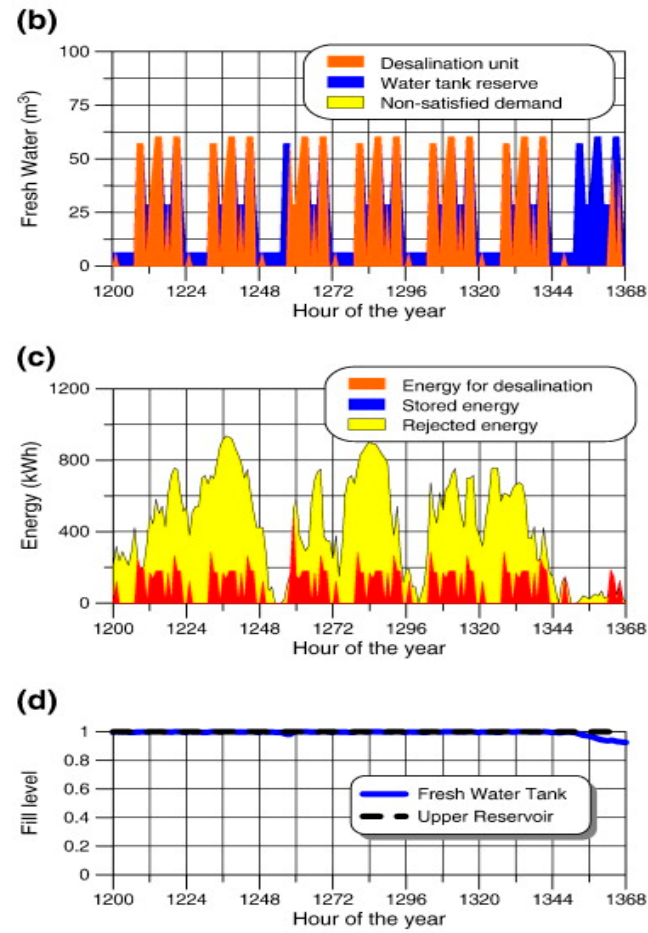
Figure 16. Plant weekly performance during a winter: ( a ) energy production, ( b ) water needs satisfaction, ( c ) energy consumption, ( d ) tank and reservoir contentand summer [149], reused with permission from Elsevier (license number 5491451072350).